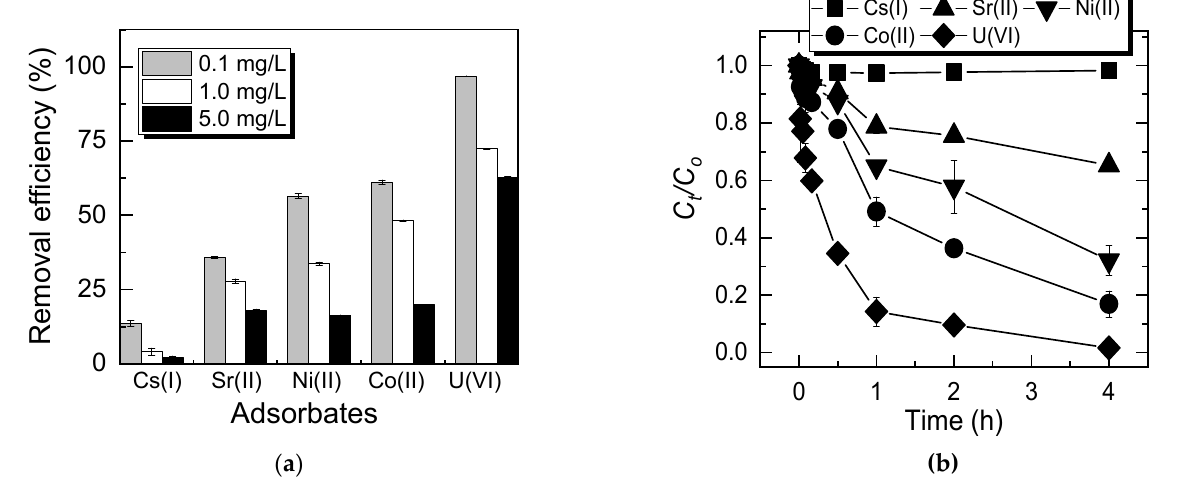
Figure 6. Competitive adsorption behavior of Co(II): ( a ) changes in removal efficiencies at various initial concentrations and ( b ) adsorption kinetics of various radionuclides at the initial concentration of 0.1 mg/L at 293 K.